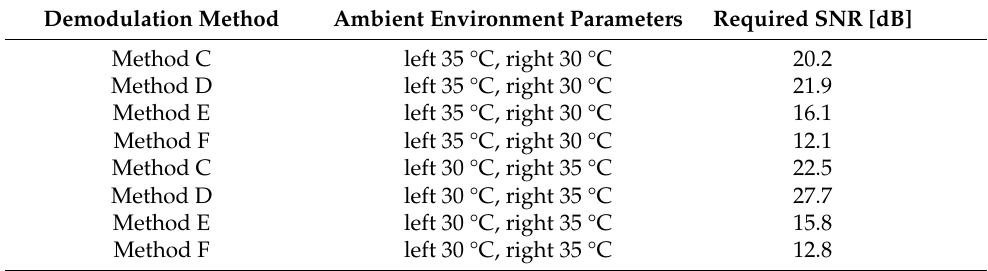
Table 5. Required SNR in heterogeneous temperature distribution.